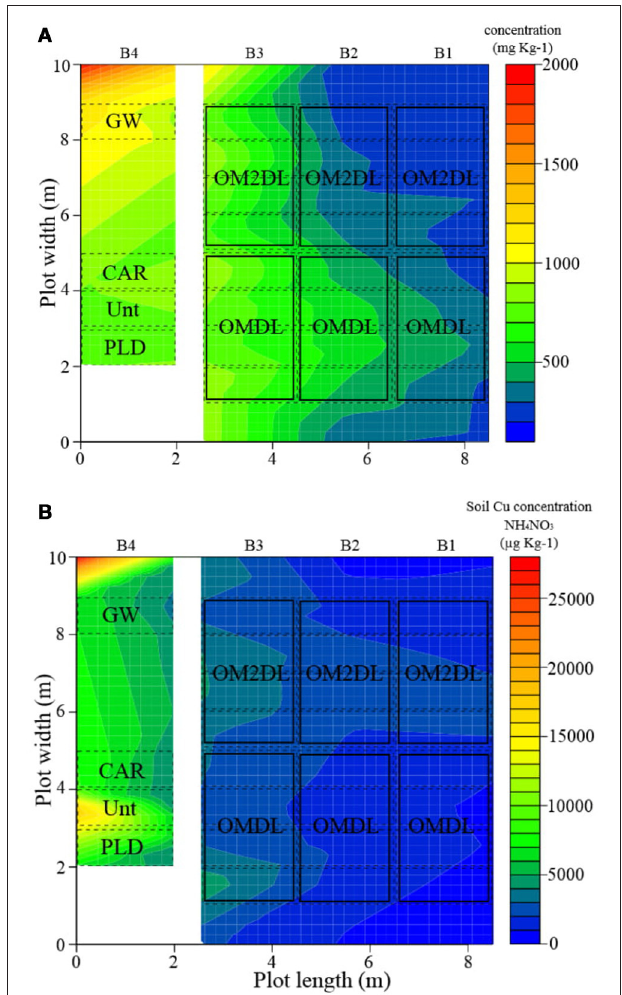
FIGURE 1 | Spatial variability of (A) total topsoil Cu (mg Cu kg − 1 DW) and (B) 1M